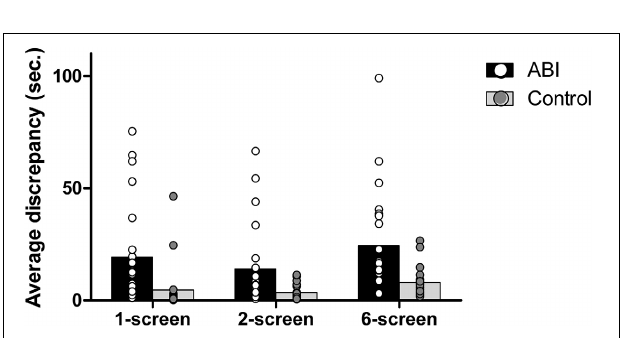
FIGURE 2 | Total task time in seconds. Dots represent individual data points.